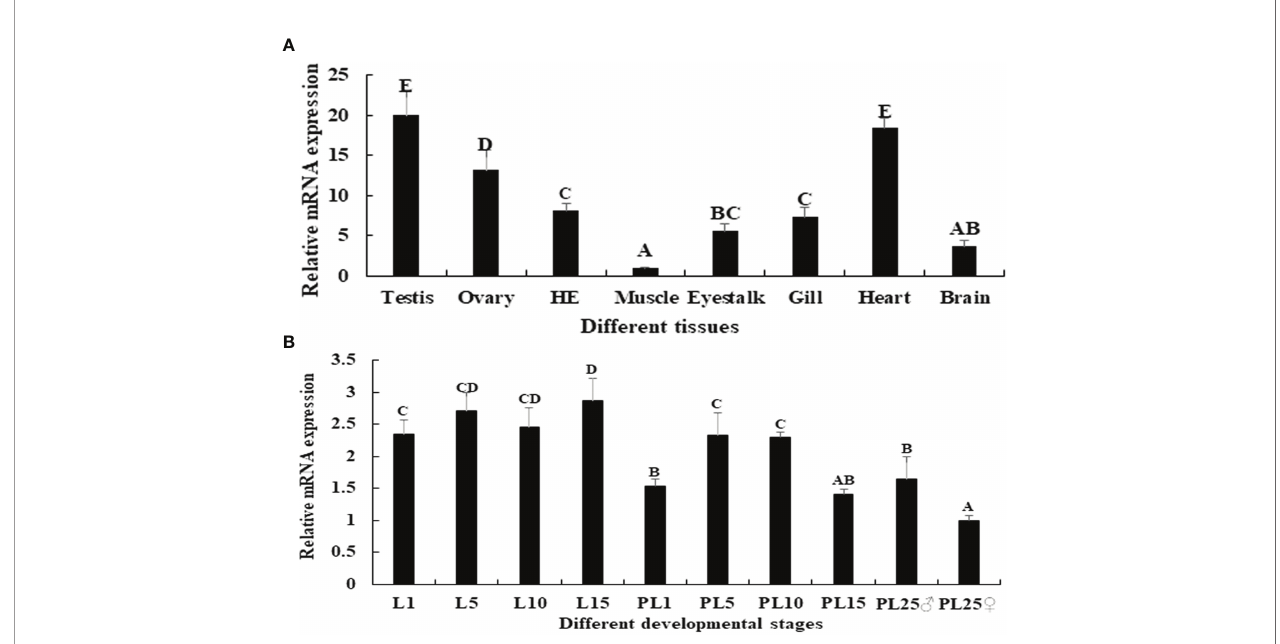
FIGURE 4 | (A) Expression characterization of Mn-PDHE1 in different tissues. (B) Expression characterization of Mn-PDHE1 in different developmental stages. The amount of Mn-PDHE1 mRNA was normalized to the EIF transcript level. Data are shown as mean ± SD (standard deviation) of tissues from three separate individuals. Capital letters indicate expression difference between different